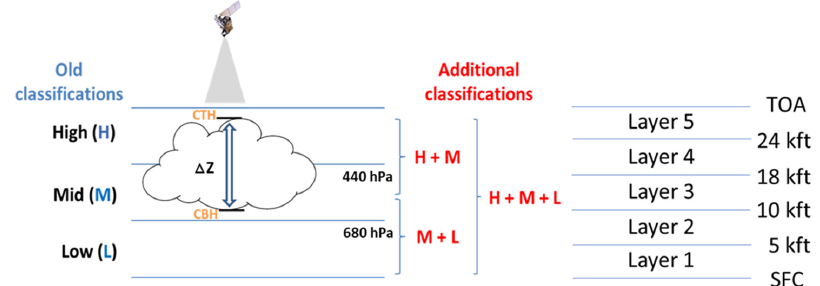
Figure 7. Expansion of cloud classifications from three to five flight-based level layers. In this example, the cloud shown on the left would previously be defined as a high cloud (H) in the original CCL